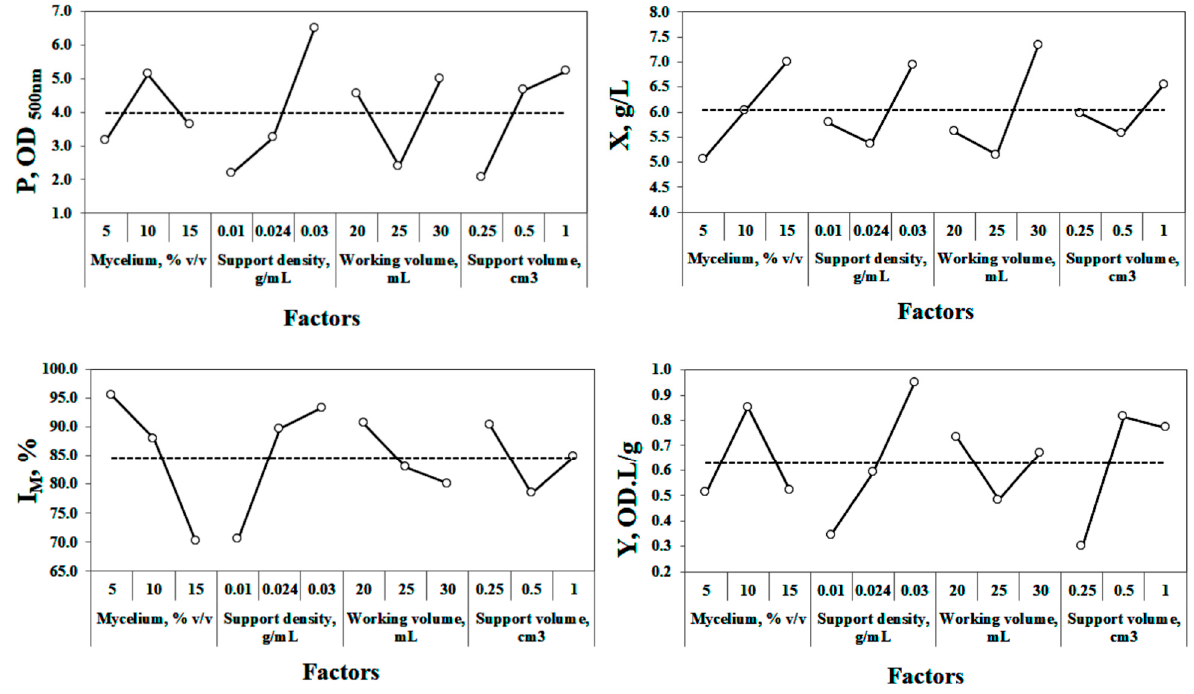
Figure 4. The effects of individual factors on each response. Pigments (P), biomass (X), immobilization capacity (I M ), pigment yield (Y).